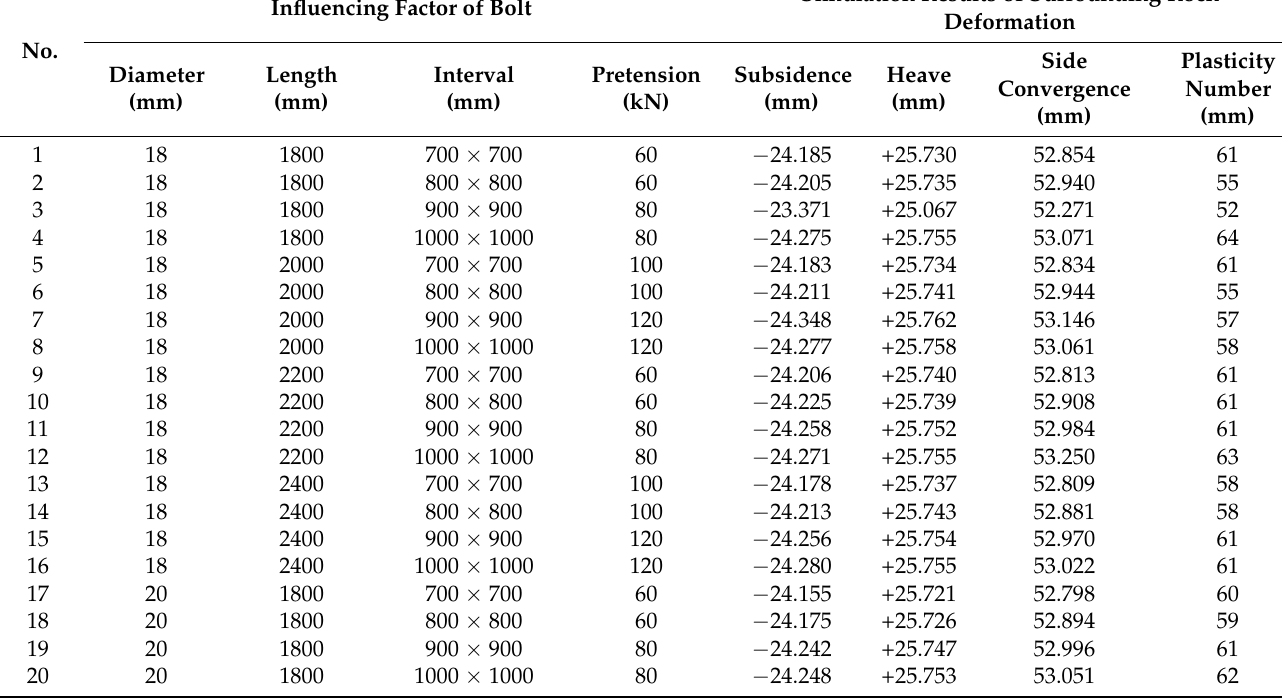
Table 5. Bolt anchoring experimental design of orthogonal numerical